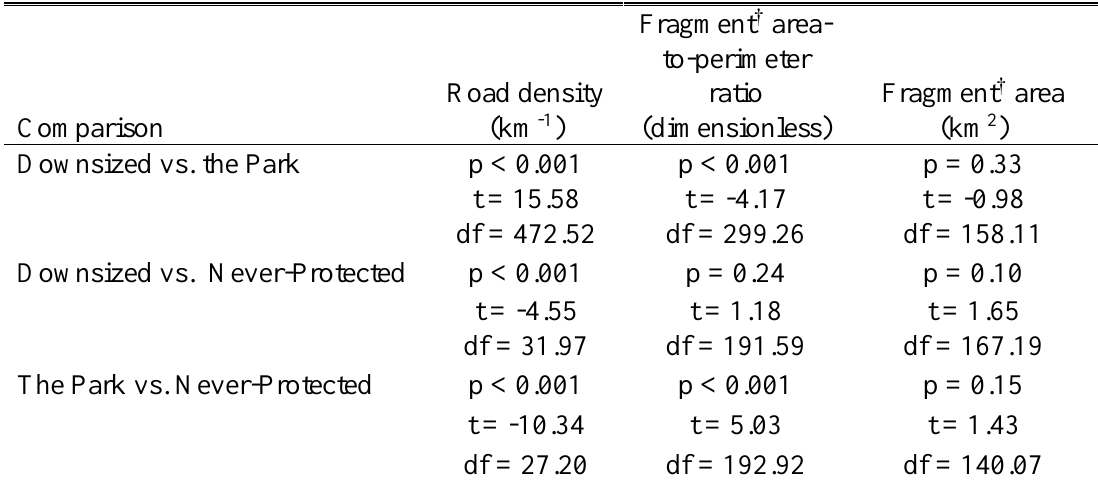
Table A1.6: Habitat fragmentation at the Park scale for forested lands – post-hoc Welch’s t-tests results from Table